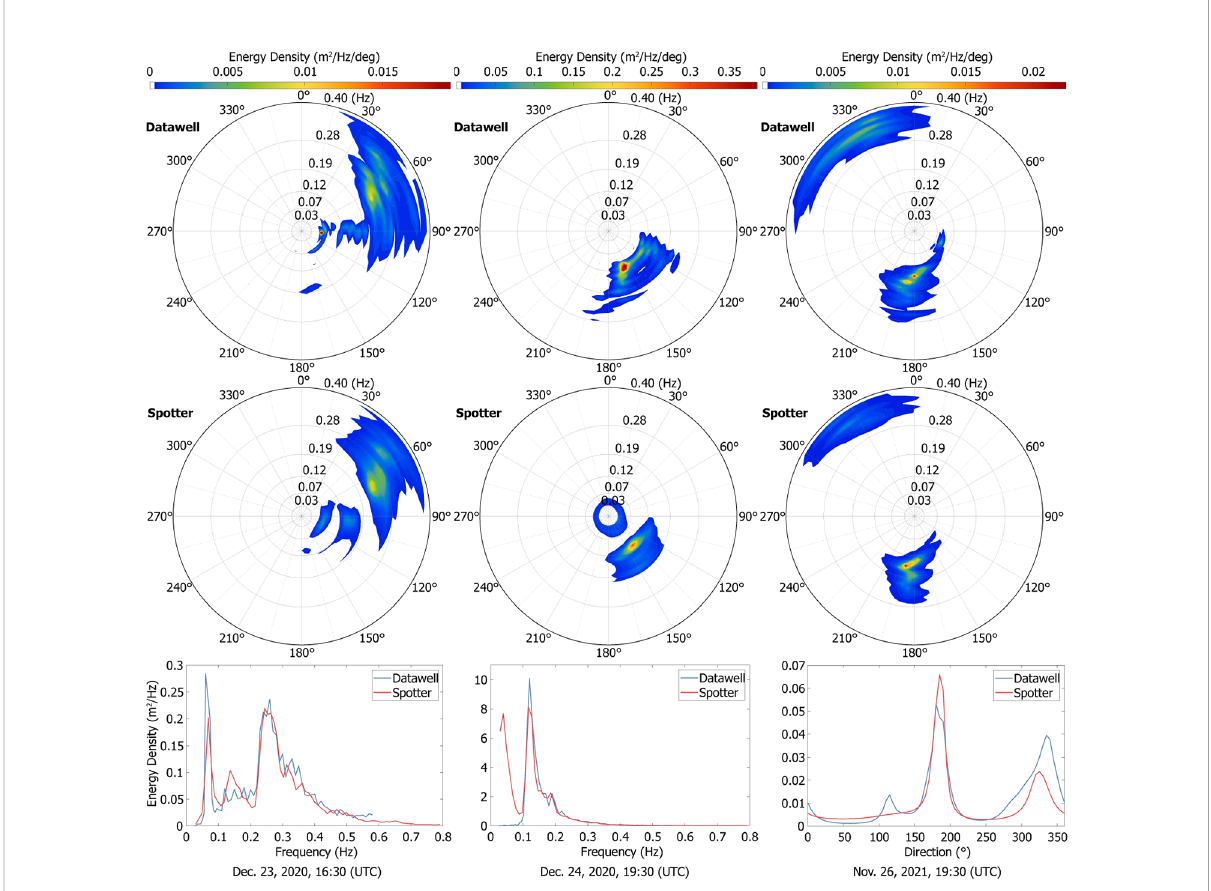
FIGURE 8 Comparison of the directional distribution of wave energy for the Datawell (top row) and Spotter (middle row) wave buoys for the three time periods shown in Table 2. The bottom left and bottom center panel show energy density versus frequency for the two buoys, the bottom right panel shows energy density versus direction for the two buoys.